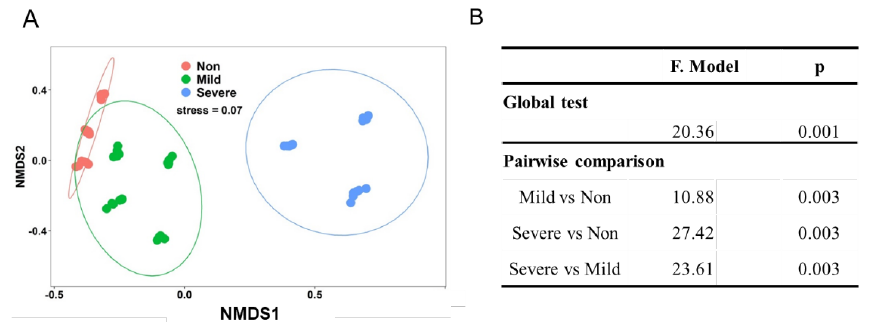
Figure 2. Bacterial diversity indices of the soils with three salinity levels: Non–salinity, Mild–salinity and Severe–salinity. The diversity index Richness denotes the bacterial variations at the taxonomic level ( A ), and PD (phylogenetic diversity) denotes variations at the phylogenetic level ( B ), in other words, evolutionary relationship. The same letters above bars denote no significant difference ( p > 0.05) among salinity levels.